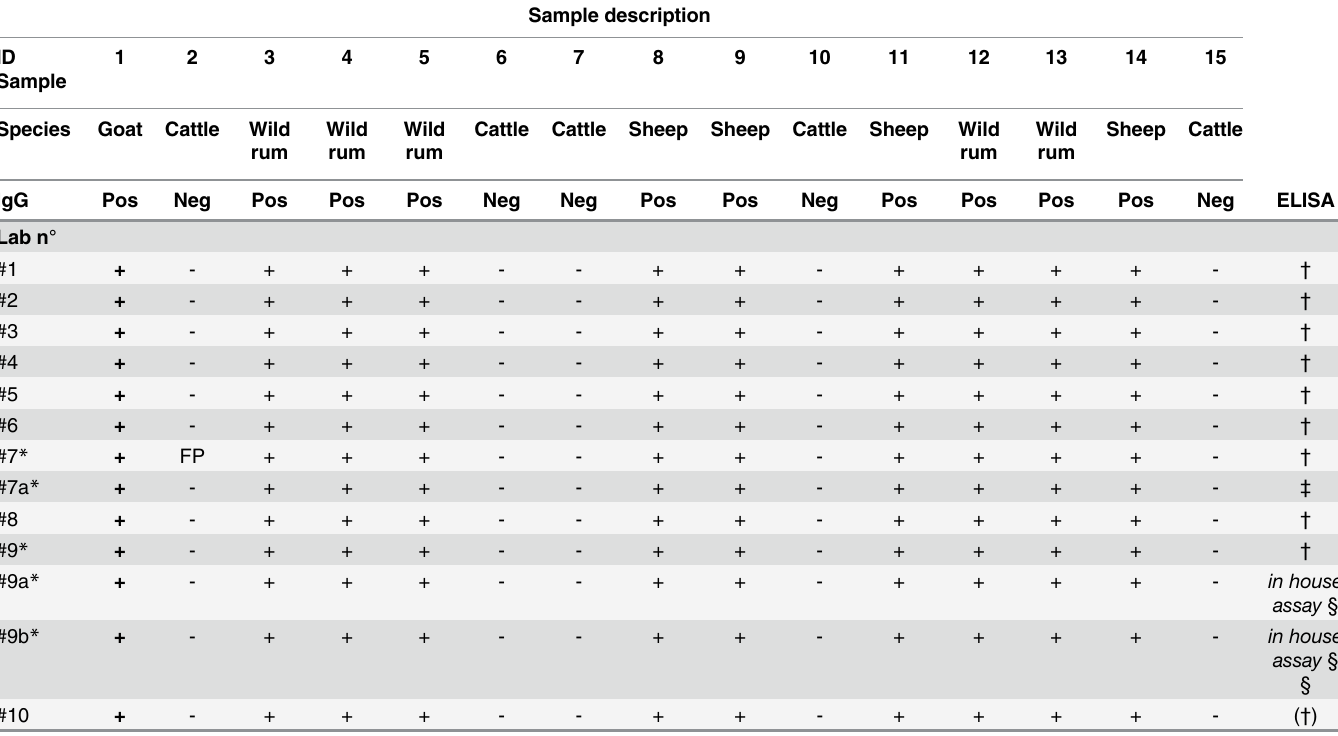
Table 4. Results of the EQA for RVF IgG antibodies detection.